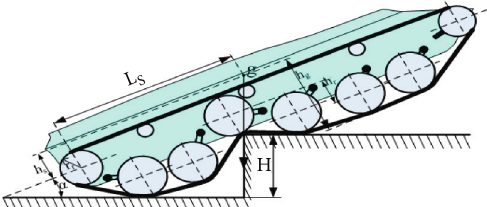
Figure 13: Key parameters of a vehicle crossing a vertical wall.